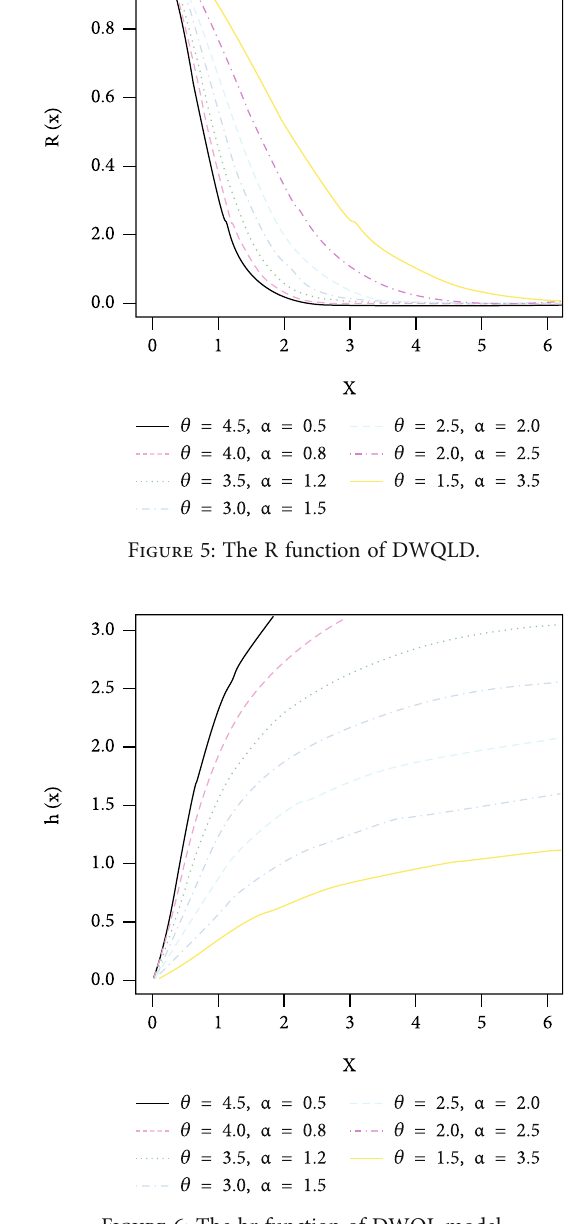
Figure 6: The hr function of DWQL model.